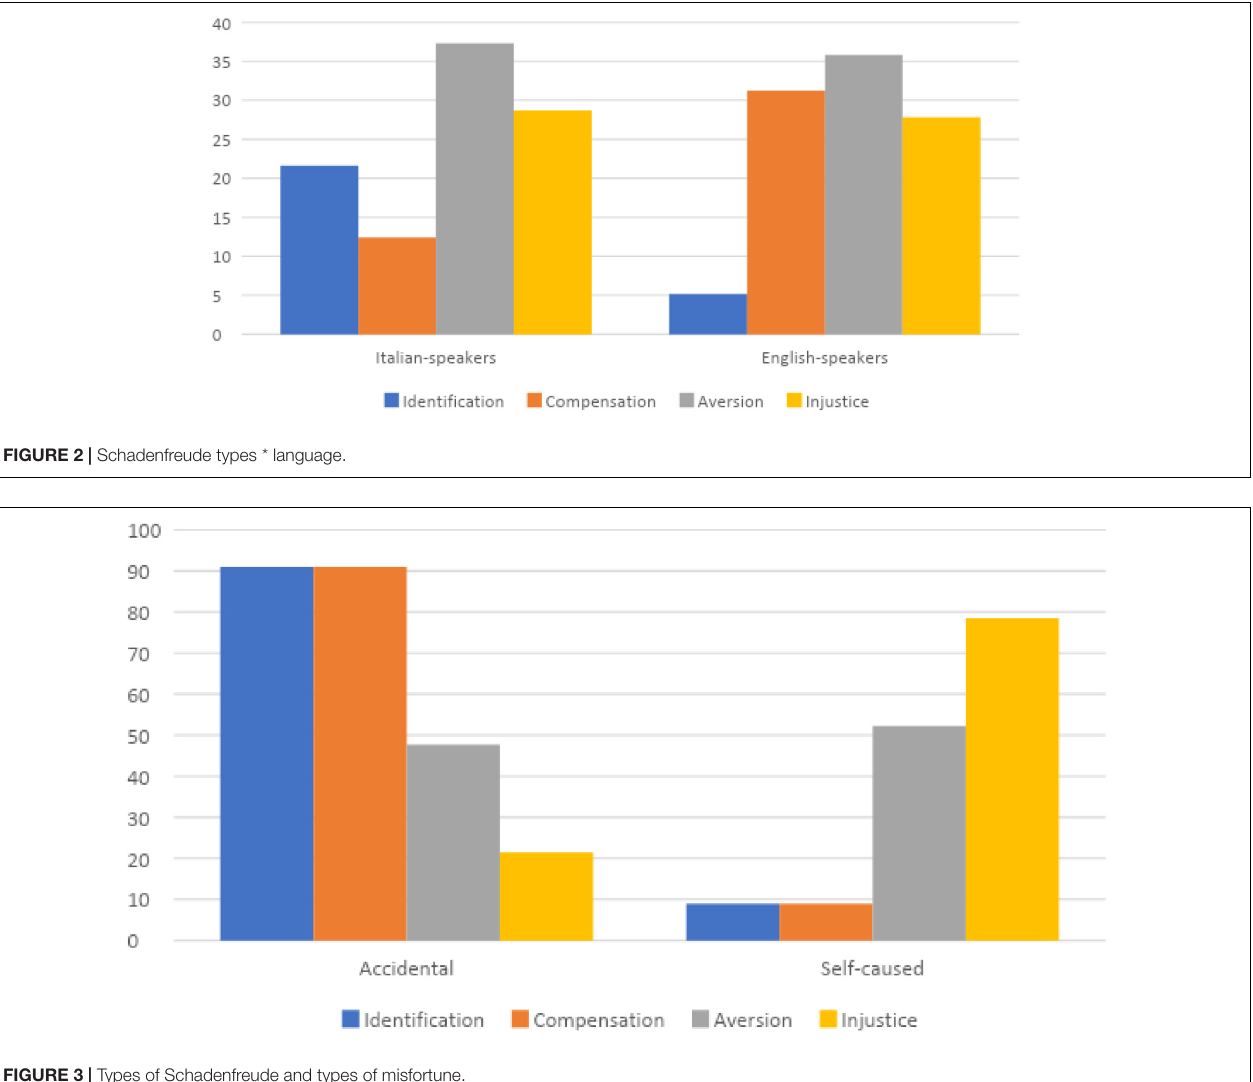
FIGURE 3 | Types of Schadenfreude and types of